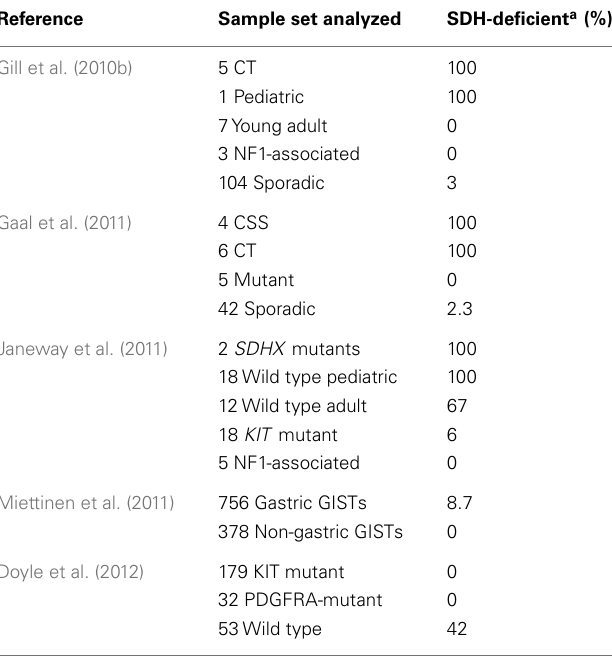
Table 2 | SDHB-deficiency in